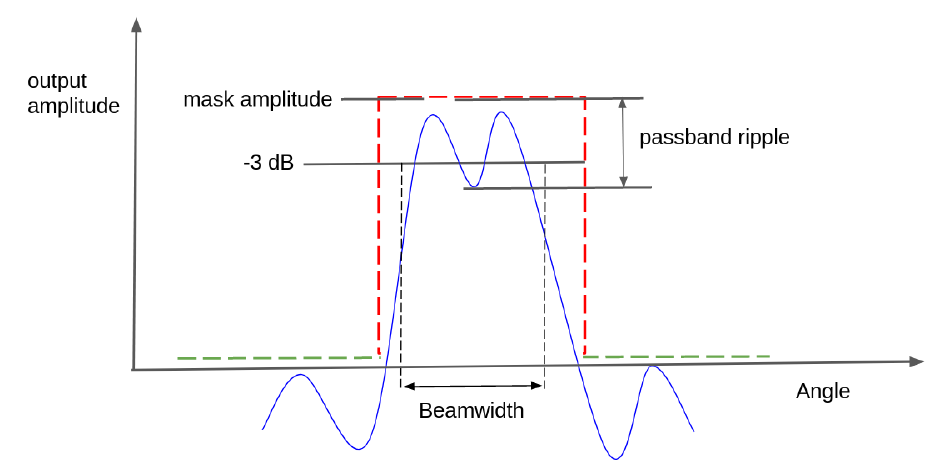
Figure 4. Example of beampattern mask (red and green lines) and an optimized beampattern response (blue line) with the evaluation measures of the passband ripple and beamwidth marked out. The red dotted line defines the mask of the main beam, whereas the green dotted line defines the max level for the allowed sidelobe